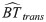
Sensory integration model for light touch cues.Triangles are gain factors, where values are given in Table 1 with the exception of the COM height h (0.96 m) and the touch reference height hTP (0.8 m or 1.2 m). Linearized inverted pendulum dynamics are implemented as a transfer function using the Laplace transform. ‘Set point’ provides the desired body orientation, which is adjusted by the light touch feedback. a-e indicate points of interest in the model. a) output of the inverted pendulum dynamics is the body angle in space. b) the sum calculates the physical horizontal distance between the finger and the body COM as it is sensed by light touch. c) the gain factor transforms the body angle as sensed by Sensors BSang to a horizontal distance BT^trans signal using the small angle approximation. d) the sum provides a sensory reconstruction of the Stimulus. e) indicates the correction of the light touch feedback through the estimated touch motion. The model is drawn to represent the signal flow in the central nervous system as compared to an engineering view with stimulus as positive input on the left and body sway as output for systems identification on the right.